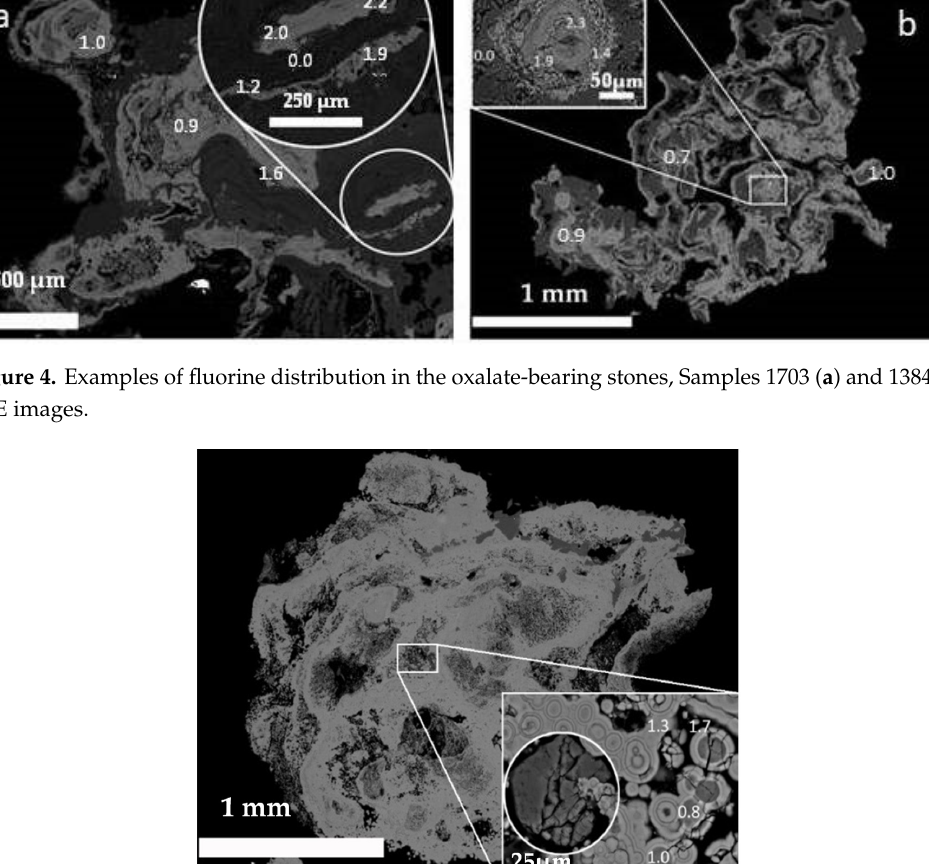
Figure 3. Fluorine distribution within the oxalate-bearing stone, Sample 10. BSE image.